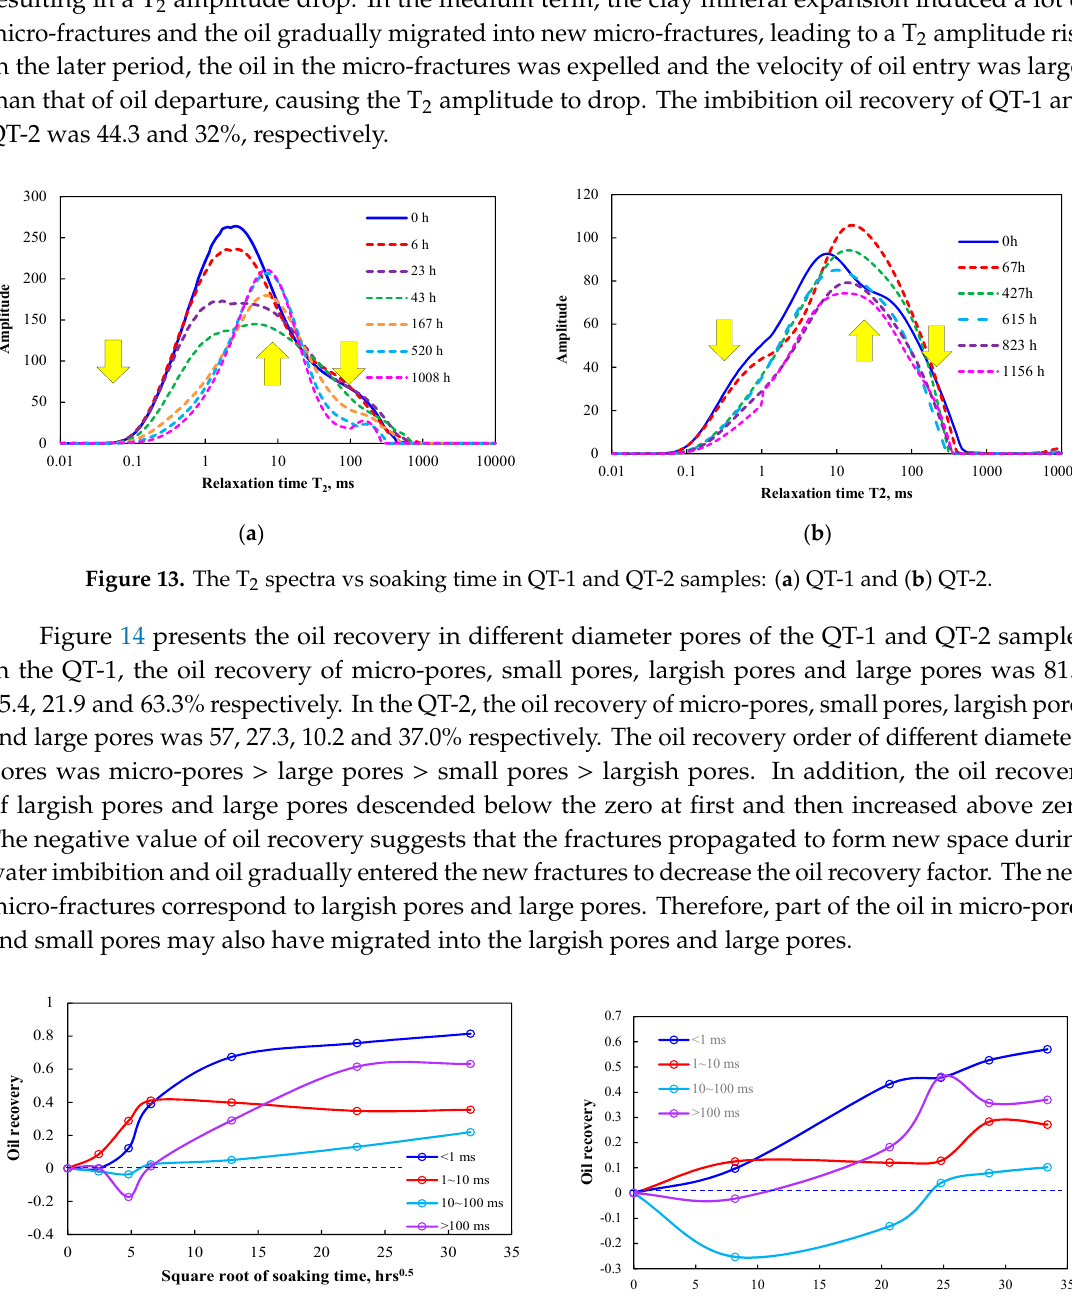
( c ) Figure 12. The magnetic resonance imaging of QT-1 sample: ( a ) 0 h, ( b ) 6 h and ( c ) 23 h.